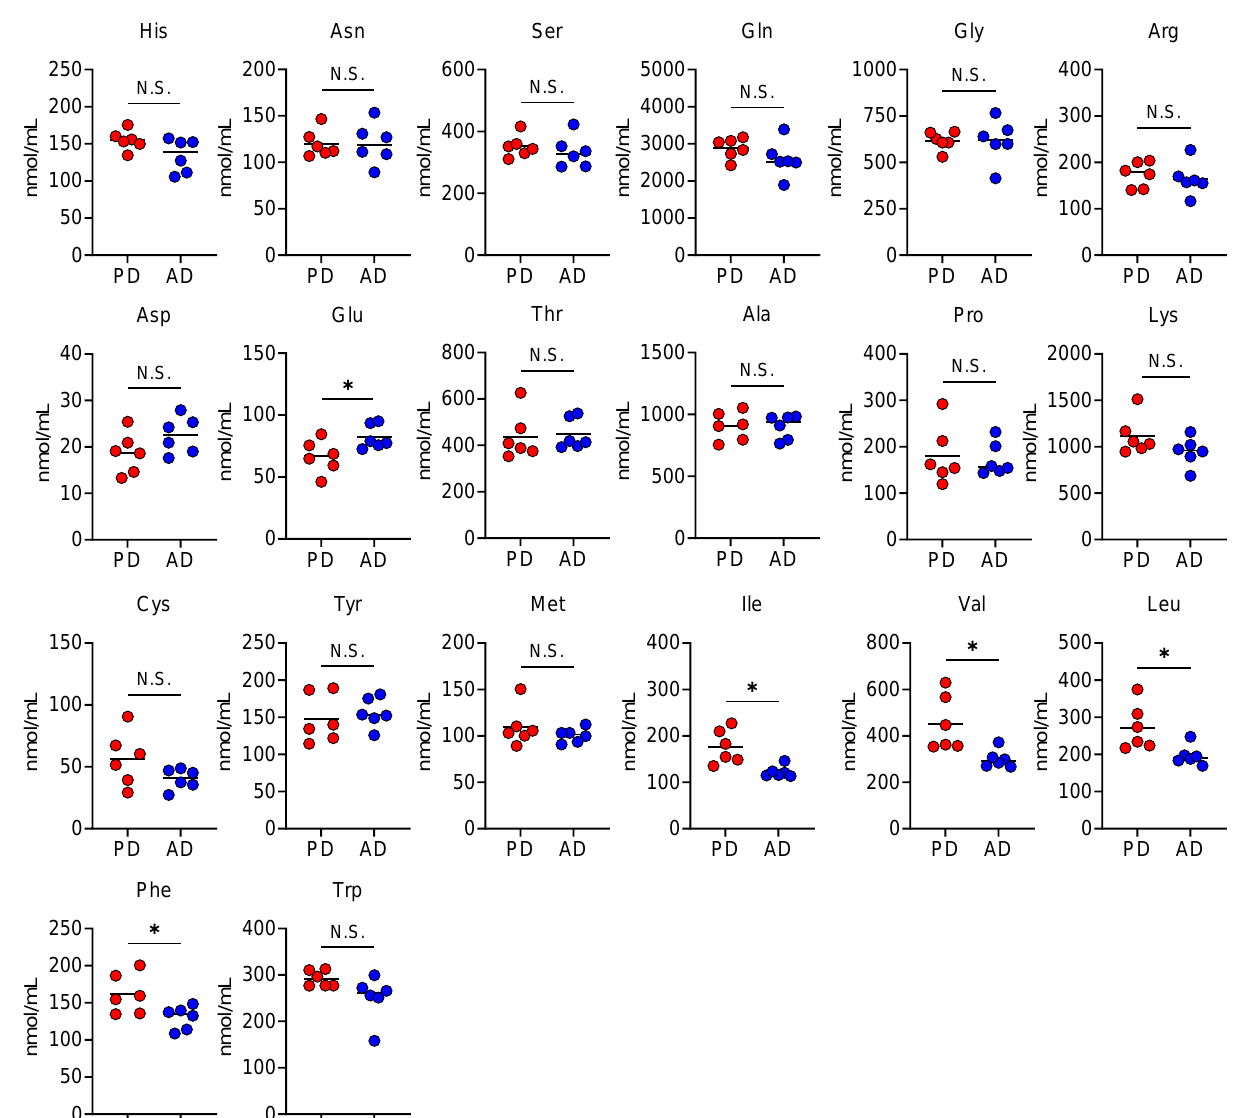
Figure 4. An amino acid-based diet alters plasma amino acid levels. Plasma levels of each amino acid in the mice fed each diet (PD: regular purified diet, AD: amino acid-based purified diet) for 2 weeks ( n = 6 in each group). Each dot represents an individual mouse, and horizontal bars indicate mean values. Statistical significance was assessed using the unpaired Welch’s t -test. * p < 0.05; N.S., not significant.